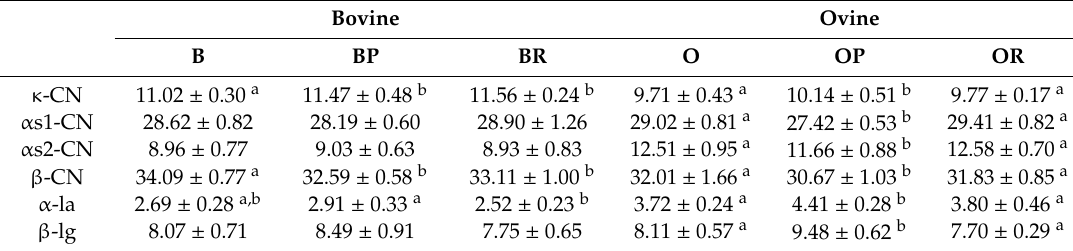
Table 3. E ff ect of microfiltration on casein fractions (% of total protein) and the main whey proteins (% of total protein) of partially defatted bovine (B) or ovine (O) milk, bovine permeate (BP), bovine retentate (BR) (mean ± SD, n = 3), ovine permeate (OP) and ovine retentate (OR) (mean ± SD, n = 5). Bovine